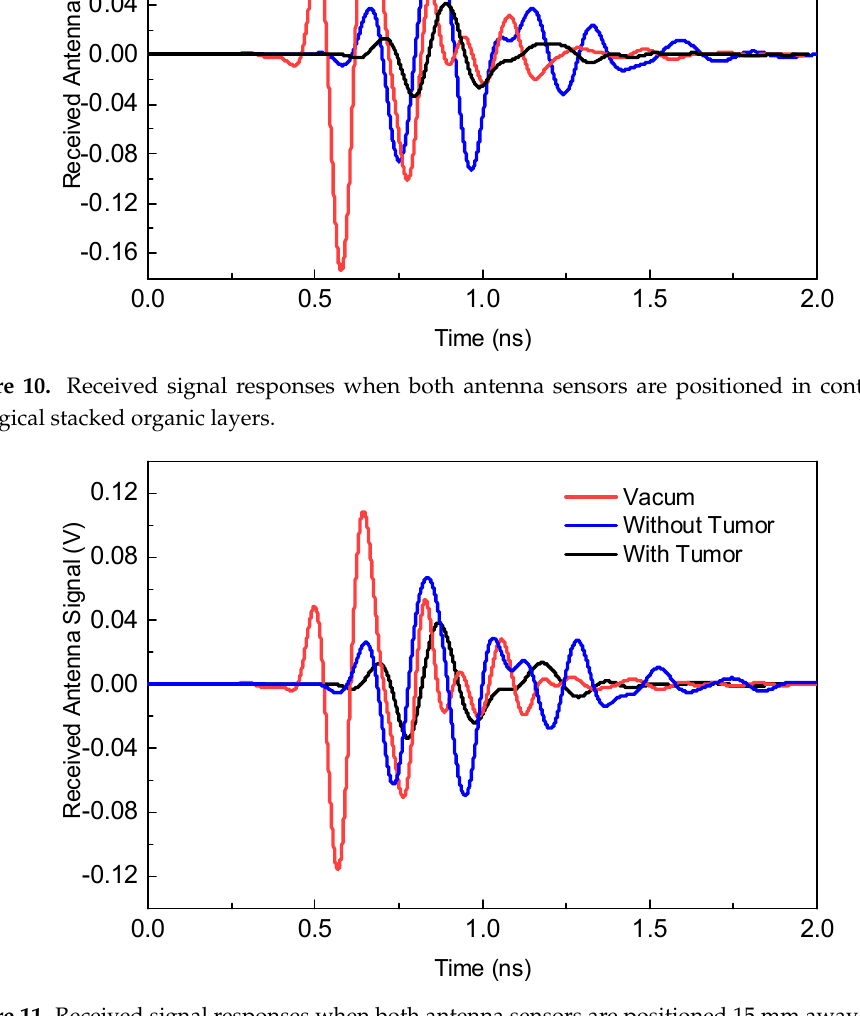
Figure 11. Received signal responses when both antenna sensors are positioned 15 mm away from the biological stacked organic layers.